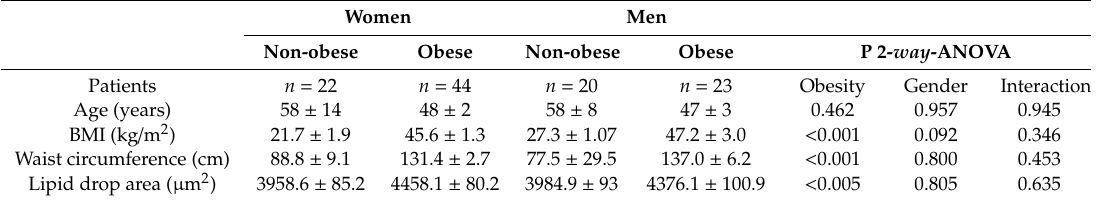
Table 1. Anthropometric features of the non-obese and obese patients included in this